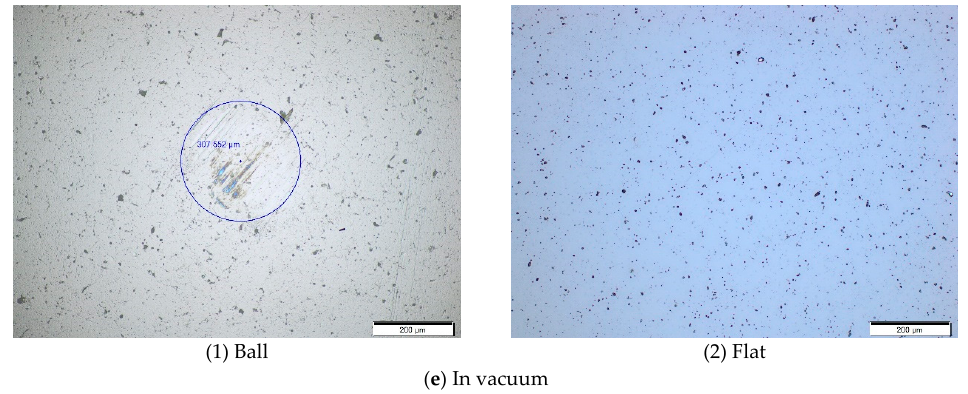
Figure 5. Worn surface images of ball under different environments at room temperature: ( a ) in alcohol environment, ( b ) in dry nitrogen, ( c ) in ambient air, ( d ) in dry hydrogen, ( e ) in vacuum and (1) ball, (2) flat and there is the worn zone within circle.